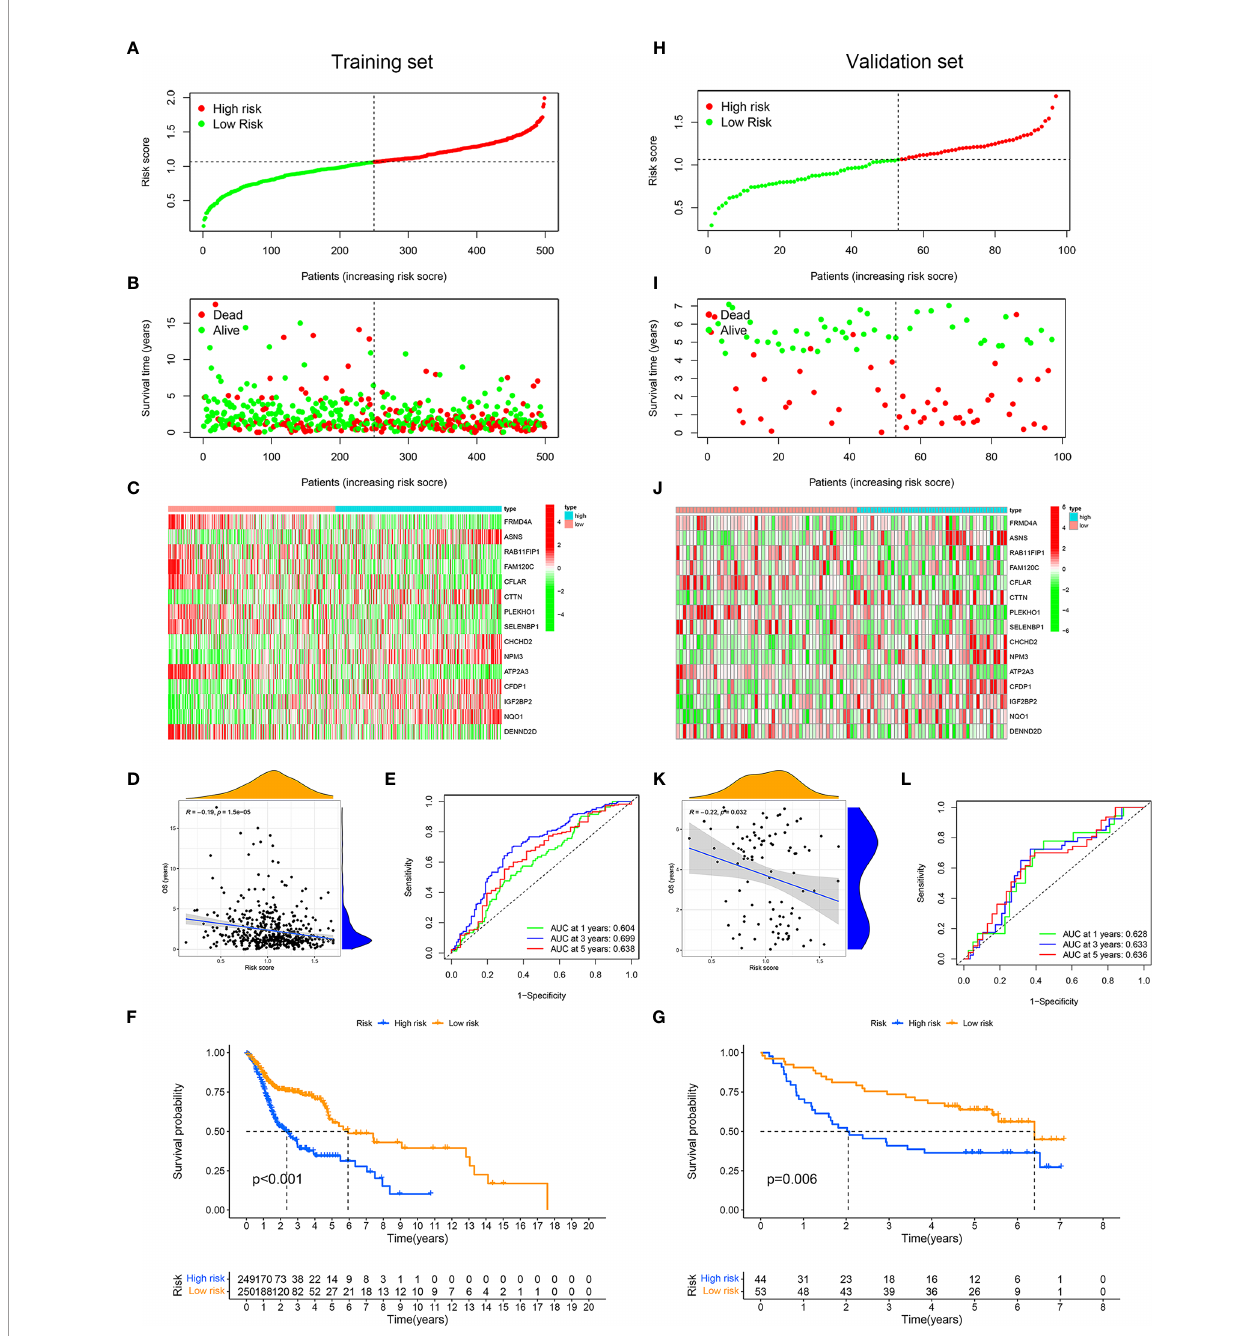
FIGURE 4 | Application and validation of the risk model for prognosis. Samples in The Cancer Genome Atlas (TCGA) dataset were designated as training set, and samples in Gene Expression Omnibus (GEO) dataset were designated as validation set. On basis of the mean risk score of samples in training set, patients were divided into high-risk (red dot) and low-risk (green dot) groups. Distribution of the risk scores of the patients in training set (A) . Distribution of survival time of patients in training set (B) . The heatmap depicting the expression difference of 15 immune-related RNA-binding proteins (RBPs) between the high-risk group and the low-risk group in training set (C) . Correlation between overall survival and risk score in training set (D) . ROC curves of risk score for predicting 1, 3, and 5 years of overall survival in training set (E) . Kaplan – Meier curves of high- and low-risk groups in training set (F) . Distribution of the risk scores of the samples in validation set (H) . Distribution of survival time of samples in validation set (I) . The heatmap showing the expression patterns of 15 immune-related RBPs between the high- and low-risk groups in validation set (J) . Correlation between overall survival and risk score in validation set (K) . Receiver operating characteristic (ROC) curves of risk score for predicting 1, 3, and 5 years of overall survival in validation set (L) . Kaplan – Meier curves of high- and low-risk groups in validation set (G)